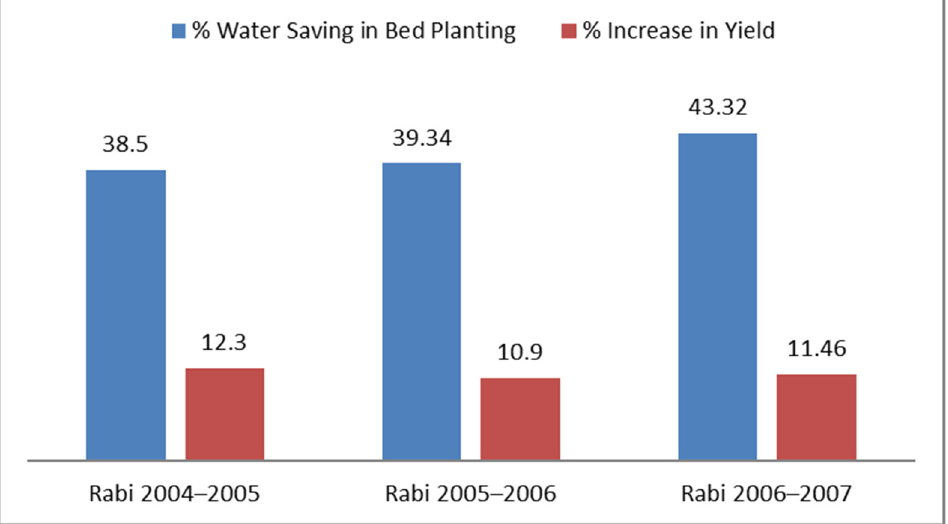
Figure 2. Wheat planting on beds at farmers’ fields under UAF technology transfer program.